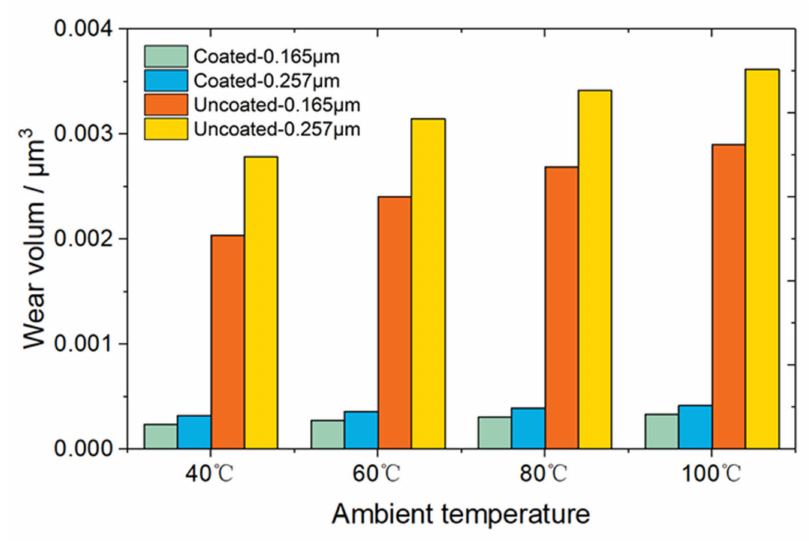
Figure 10. The wear volume for di ff erent surface conditions at various ambient temperatures in a cam cycle under the normal